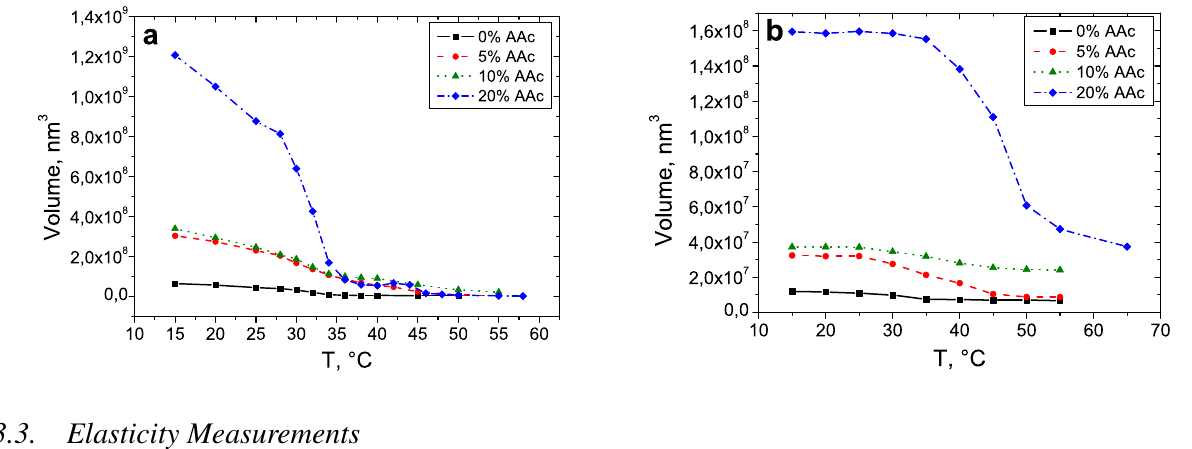
Figure 7. Temperature dependence of microgel particle volume (a) in bulk and (b) deposited on gold synthesised with 0% (squares), 5% (circles), 10% (triangles) and 20% (rhombs) AAc contents measured by DLS and SFM, respectively.